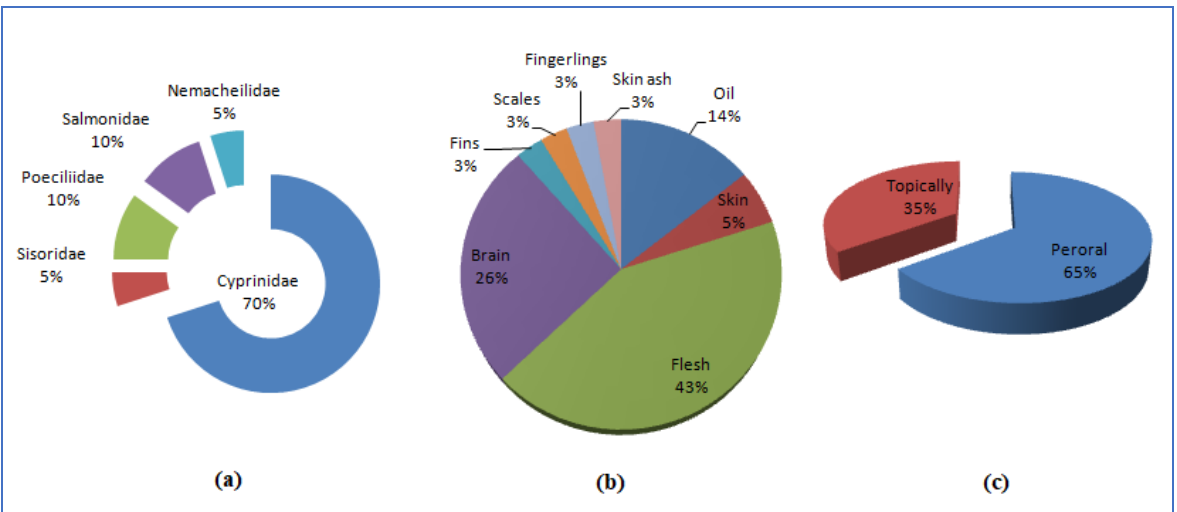
Figure 2. ( a ) Percentage and distribution of families;( b ) percentage and number of parts used; ( c ) percentage of application types. Table 2. Cultural and ethno-medicinal uses of fishes in the Vale of Kashmir.